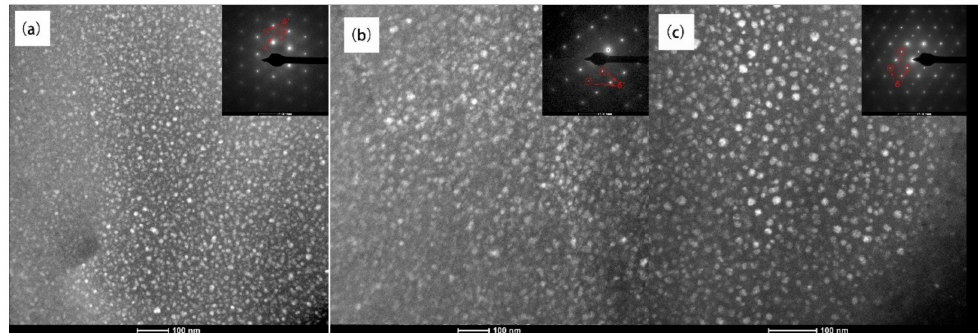
Figure 4. Transmission electron microscopy (TEM) dark-field micrographs of Al-5.5Mg-xLi-0.1Zr (wt%) alloy with di ff erent Li content: ( a ) 1.6 wt%; ( b ) 2.0 wt%; ( c ) 2.5 wt%, showing dense distribution of δ ’ phases in the as-cast alloys.